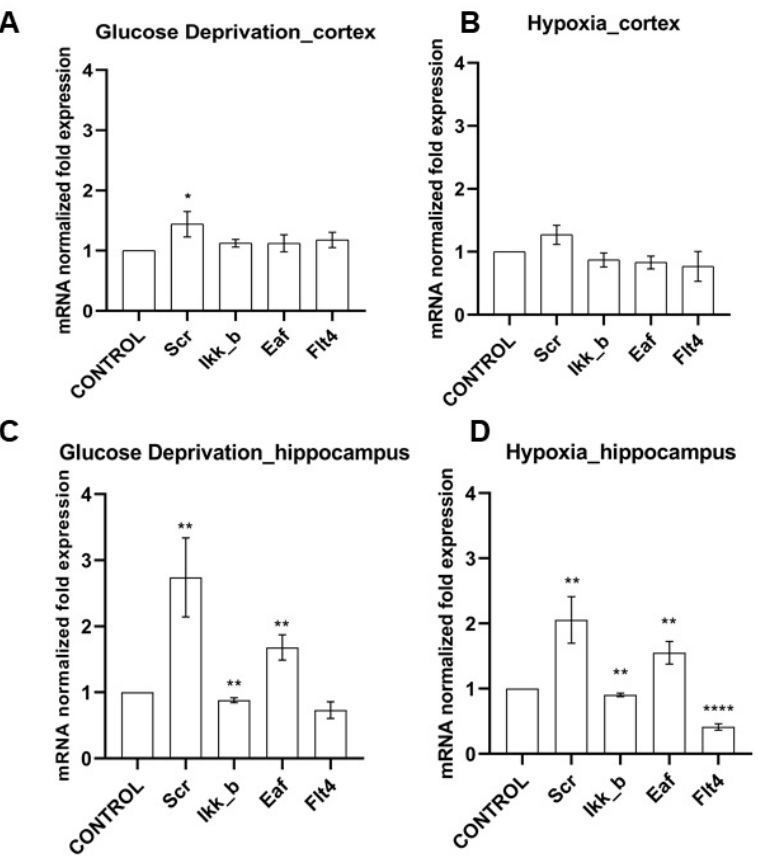
Figure 2. Features of kinase gene expression on day 7 of the post-hypoxic period. Data are normalized to the intact cultures (Control). * p < 0.05, ** p < 0.01, **** p < 0.001, the Mann-Whitney U test.